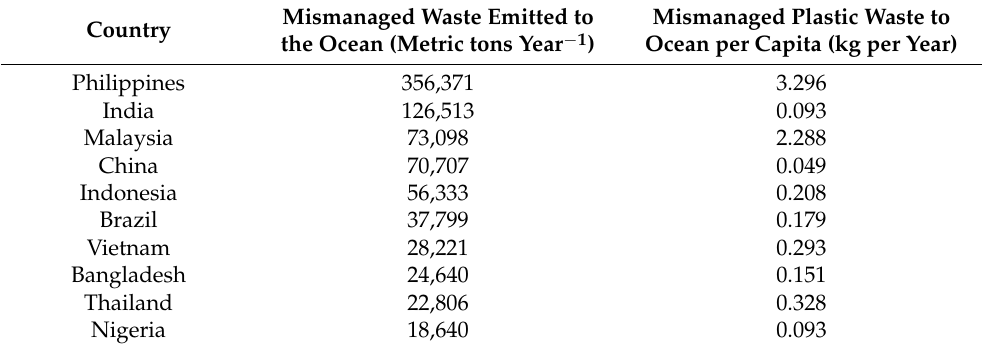
Table 1. List of countries generating the highest amount of waste that reached the ocean in 2019. Mismanaged Waste Emitted to Mismanaged Plastic Waste to Country the Ocean (Metric tons Year − 1 ) Ocean per Capita (kg per Year) Philippines 356,371 3.296 India 126,513 0.093 Malaysia 73,098 2.288 China 70,707 0.049 Indonesia 56,333 0.208 0.179 0.293